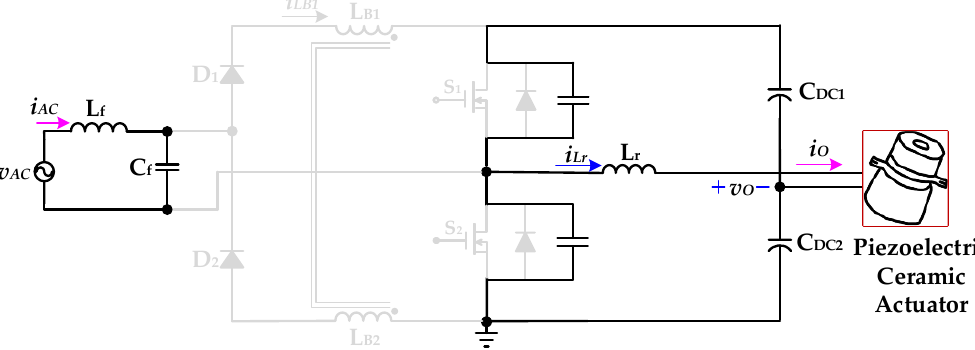
Figure 10. Operation Mode 5 of the proposed drive circuit for the piezoelectric ceramic actuator.